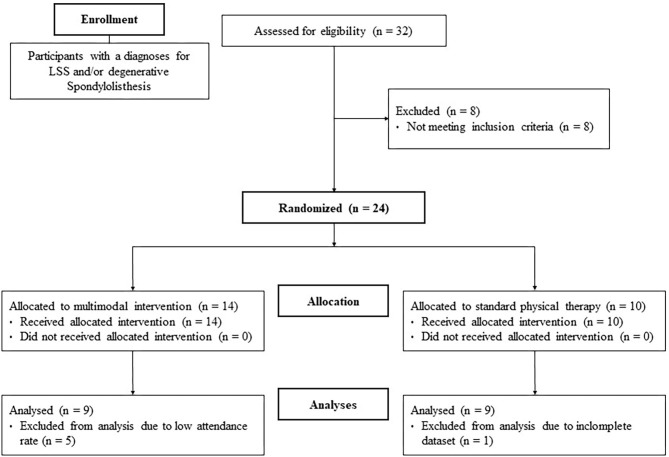
Flow chart of the study design.